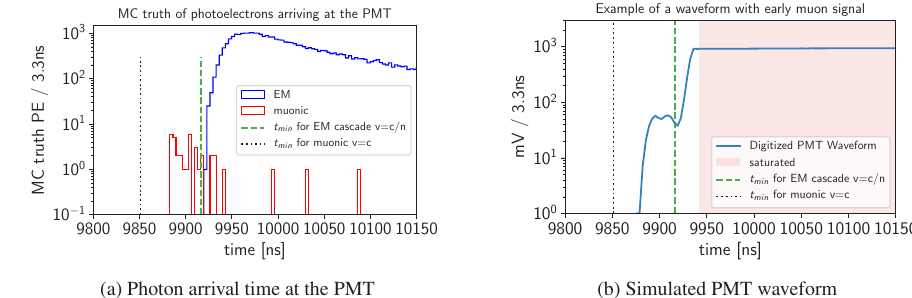
Figure 1. Sketch of the event signature of muons produced in hadronic showers. Here, the Cherenkov light emitted by the muons arrives earlier at the sensors than the Cherenkov light emitted by particles at the end of the particle shower.